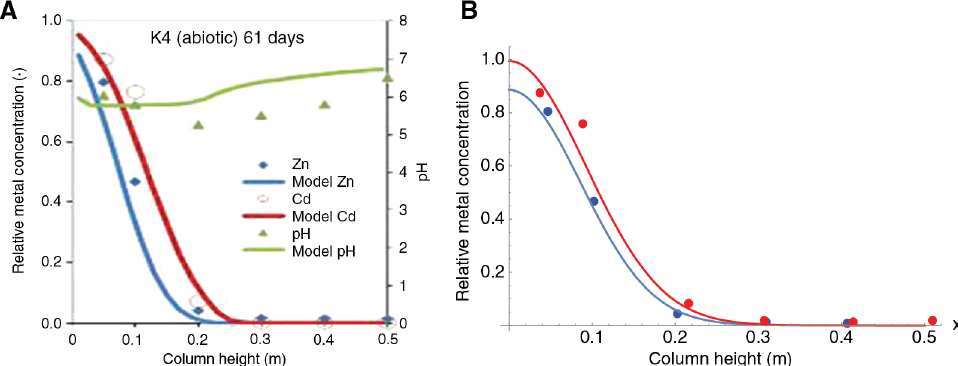
Figure 1: (A) Zn and Cd removal profile with pH variation in K4 after 61 days. (B) Comparison between theoretical pre- dictions and simulation results.